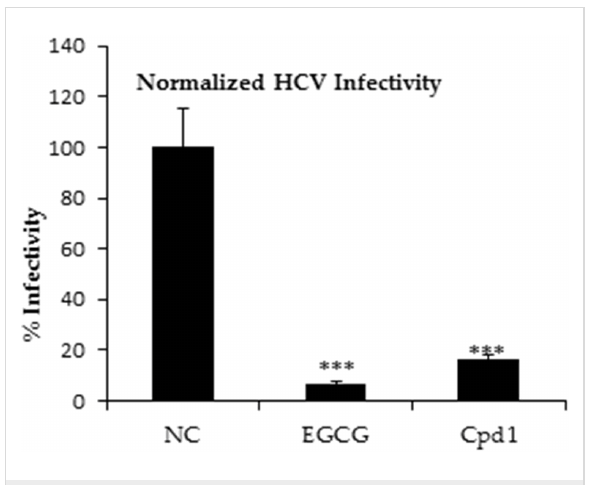
Figure 5: HCV assay: NC = negative control, EGCG = positive control, Cpd1 = lanyamycin ( 1 / 2